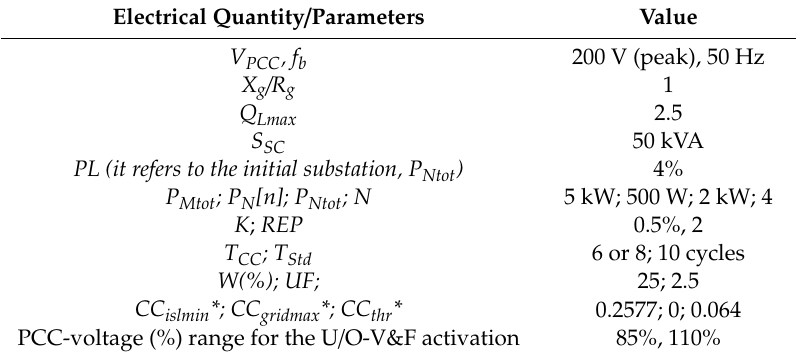
Table 1. Electrical quantities / parameters of the system and parameters of the anti-islanding